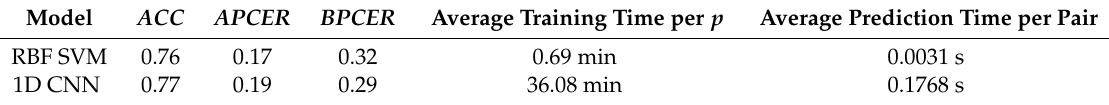
Table 2. Performance metrics of different classifiers: the average training time is computed as the mean of training times over distinct values of p . We define the average prediction time as the mean of the time (measured over 100 examples) that it takes for our models to classify one image